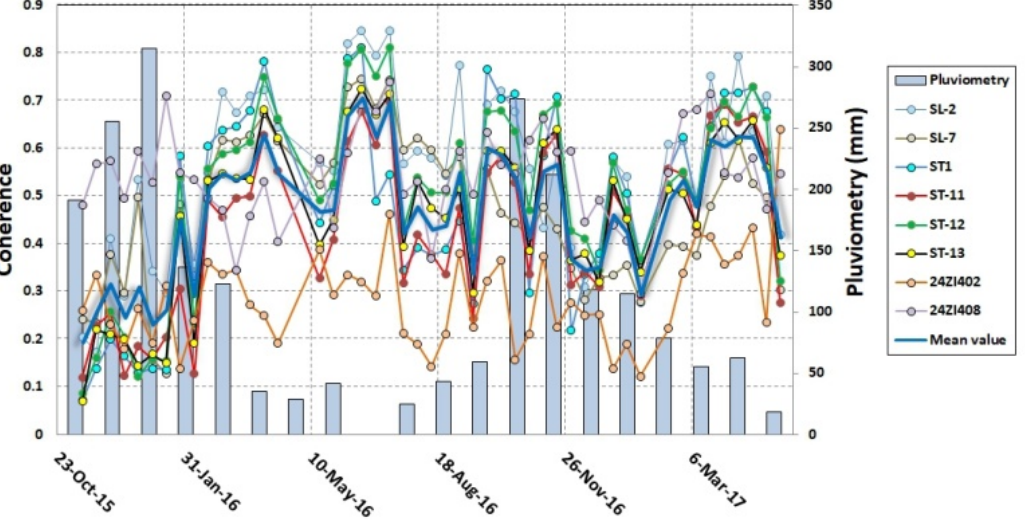
Figure 12. Multitemporal TSX coherence and local pluviometry.